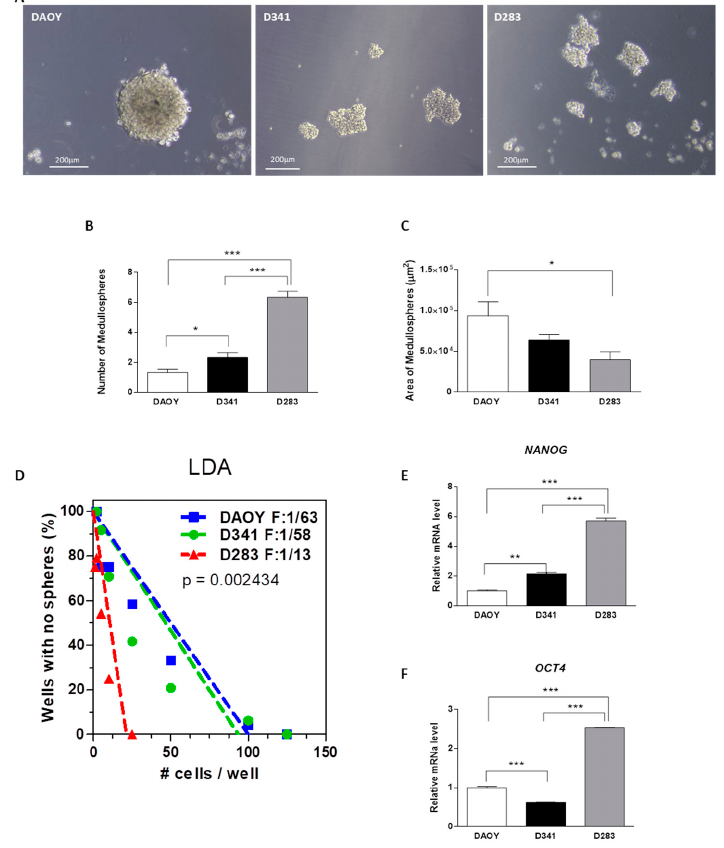
Figure 2. Medullospheres (MS) assay. Representative images of MS obtained with MB cell lines ( A ). MS quantitative analysis: Number ( B ), area ( C ). The fraction of wells without MS plotted against cell numbers per wells (LDA, D ). Protein expression and relative densitometry of CD133 ( E ) Gene expression of NANOG ( F ) and OCT4 in basal conditions; DAOY expression levels are taken as 1. Data are shown as a mean of three biological replicates ± SEM. Differences were tested with Student’s t - test. * p < 0.05, ** p < 0.001; *** p < 0.0001. Bars: 200 μ m.